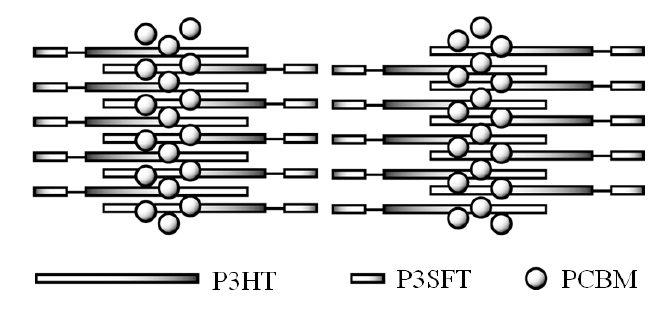
Figure 1. The image of self-assembly of diblock copolymer with semifluorinated carbon and hydrocarbon segments and PCBM on